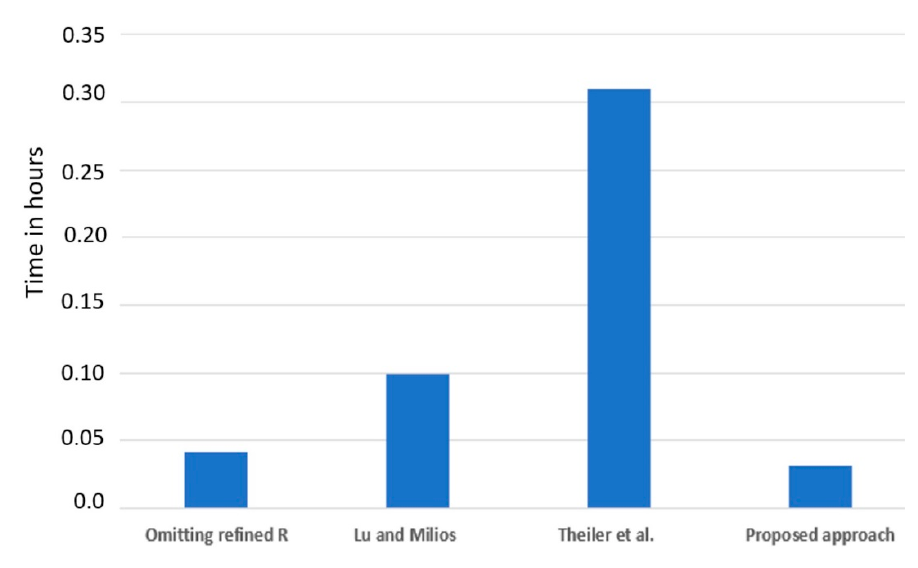
Figure 11. Results of the global registration time for each tested method.